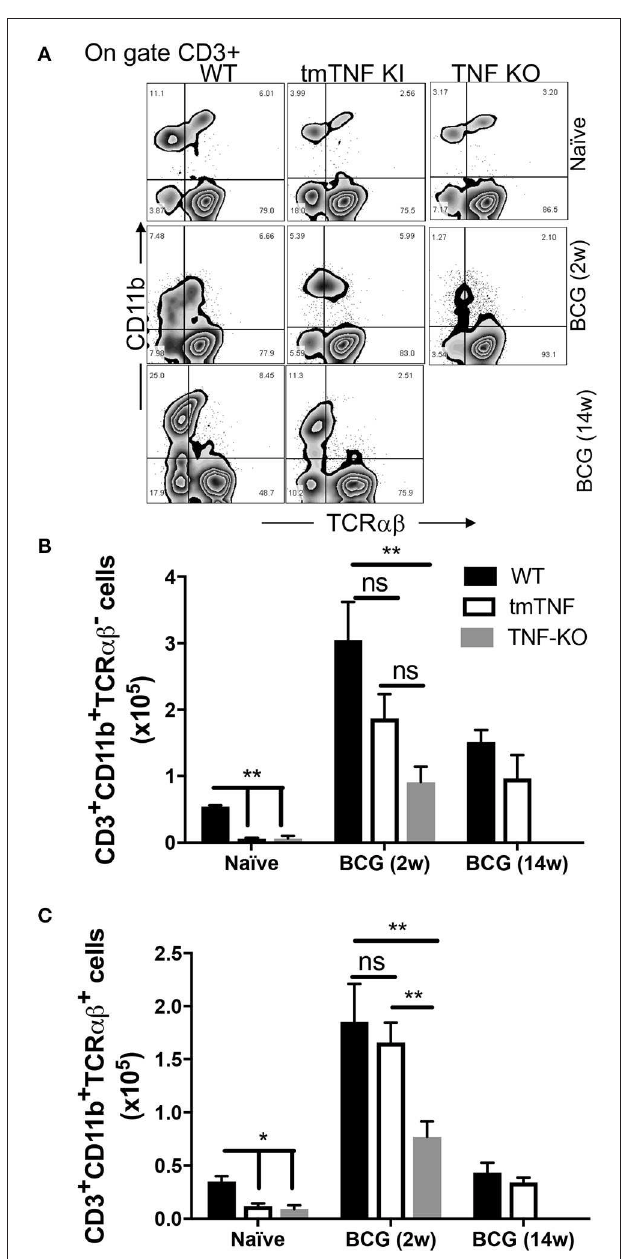
FIGURE 4 | tmTNF regulates the presence of CD3 + TCR αβ − and CD3 + TCR αβ + myeloid cells in the pleural cavity after a BCG infection. Wild type (WT), transmembrane TNF (tmTNF KI)-expressing and TNF knockout (TNF KO) mice were infected inside the pleural cavity with BCG. The animals were sacrificed at 2 weeks (BCG 2w) and 14 weeks (BCG 14w) post-infection, and a non-infected group (naïve) was used as the control. (A) Representative zebra plot: the CD3 + cells were delimited, and the co-expression of CD11b and TCR αβ were evaluated inside this gate in each group. The absolute numbers of CD3 + CD11b + TCR αβ − (B) and CD3 + CD11b + TCR αβ + (C) subpopulations are shown; these numbers are obtained by measuring the relation between the percentage of cells (obtained by flow cytometry) with the total number of cells recovered from the pleural cavity. The data are expressed as the mean ± SD of n = 4–8 mice, three independent experiments. A statistical analysis was performed by two-way ANOVA with multiple comparisons, following by a Tukey test. ** p < 0.01; ns = not statistic difference.